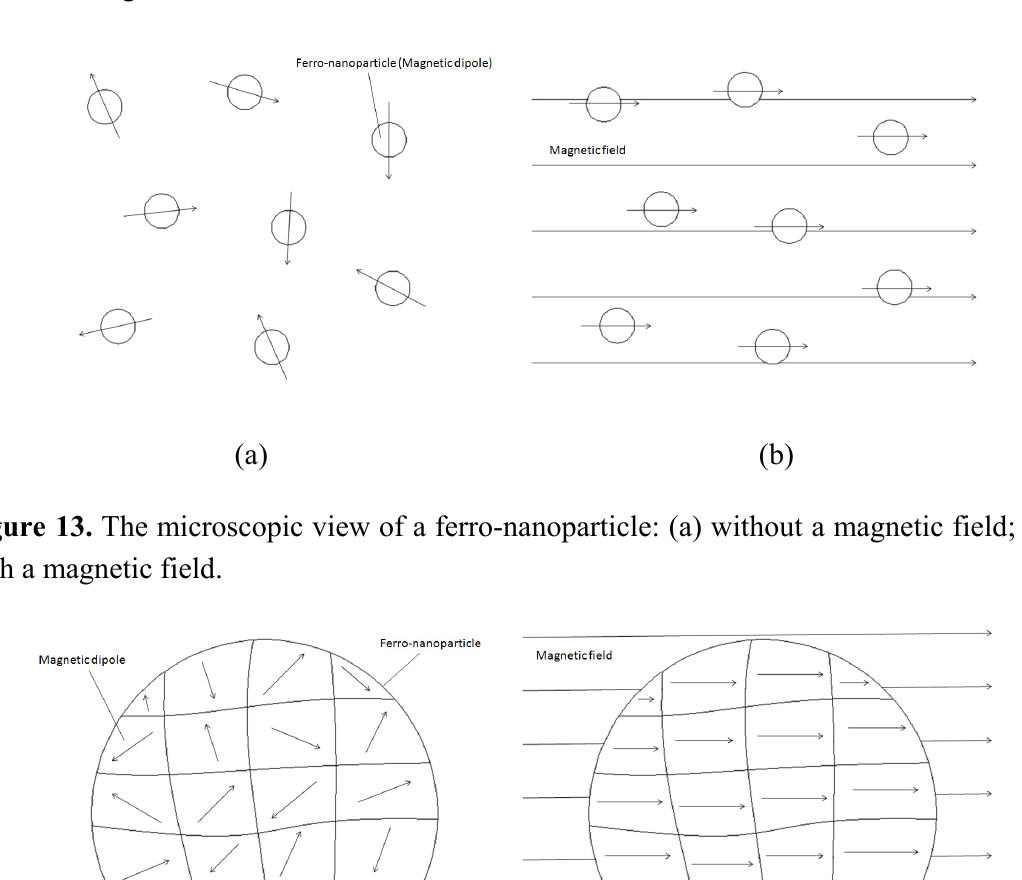
Figure 12. The macroscopic view of ferro-nanoparticles: (a) without a magnetic field; (b) with a magnetic field.